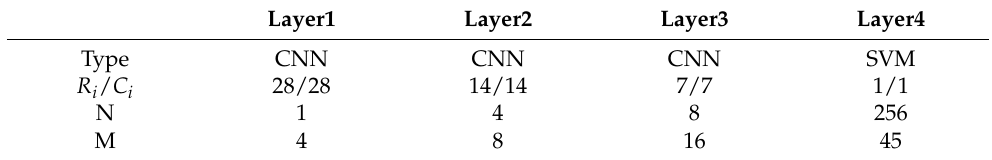
Table 2. Structure of the CNN-SVM algorithm.